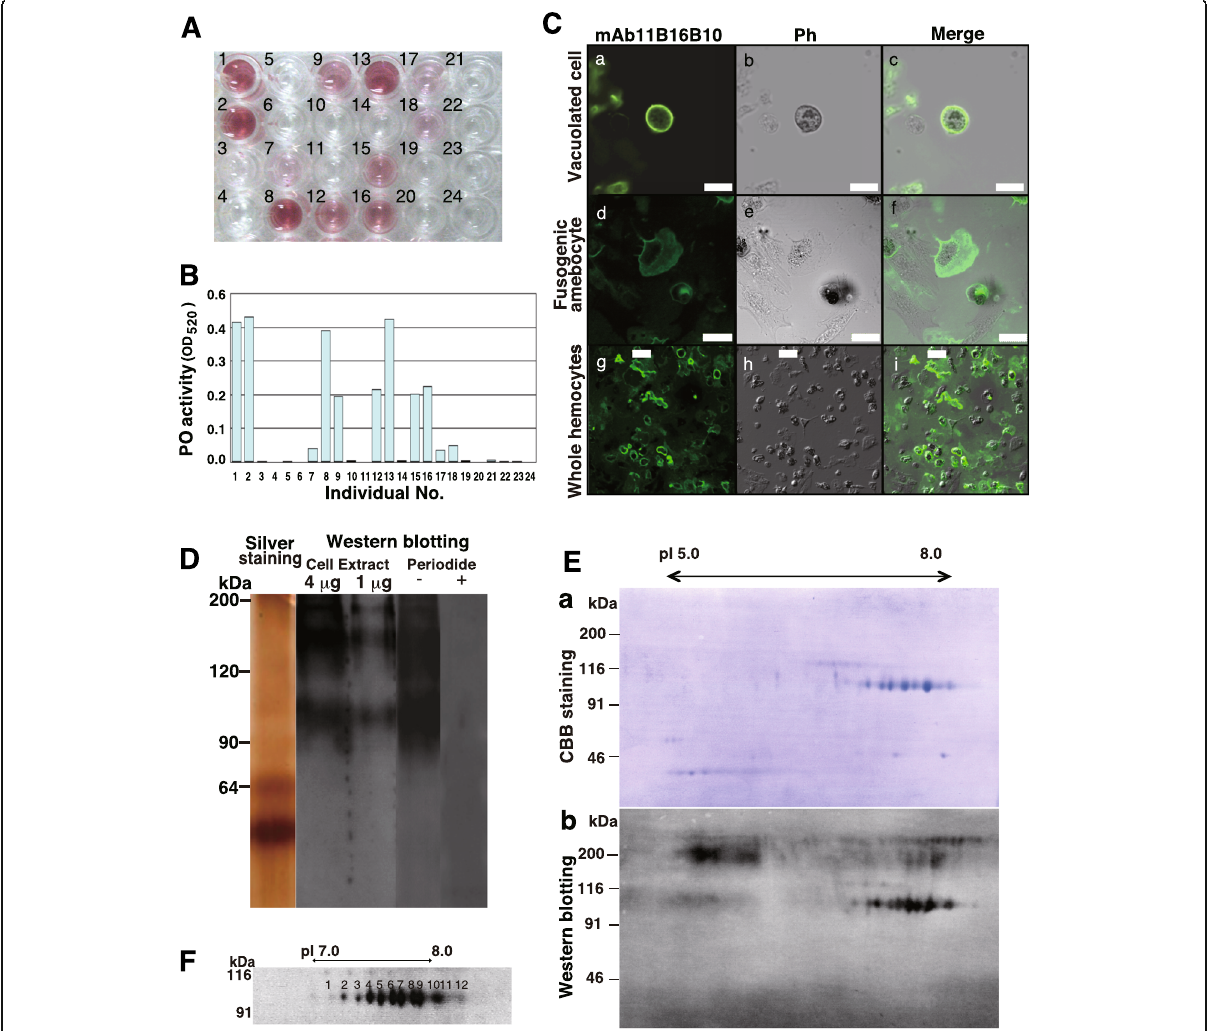
Fig. 2 Immunochemical analysis performed with the phenol oxidase (PO)-releasing antibody mAb11B16B10. A mAb11B16B10-induced colorimetric PO activity of hemocytes from 24 individuals. B mAb11B16B10-induced OD 520 values from a ( n = 3). Numerals indicate individuals in a . C Immunostaining of hemocytes. Images of vacuolated cells a – c , fusogenic amebocyte d – f and whole hemocytes g – i are shown. mAb11B16B10 staining a and d and phase-contrast images b and e were combined to generate the merged images c and f . Scale bars in a – f = 10 μ m. Scale bars in g – i = 20 μ m. D Western blotting of hemocyte proteins using mAb11B16B10 (Cell Extract 4 μ g and 1 μ g) and the periodate treatment before ( − ) and after (+). E 2D-PAGE analysis of hemocyte proteins stained with Coomassie Brilliant Blue (CBB) a and immunoblotted with mAb11B16B10 b . F Enlarged typical view of the gel corresponding to a region encompassing 7.0 – 8.0 pI and 100